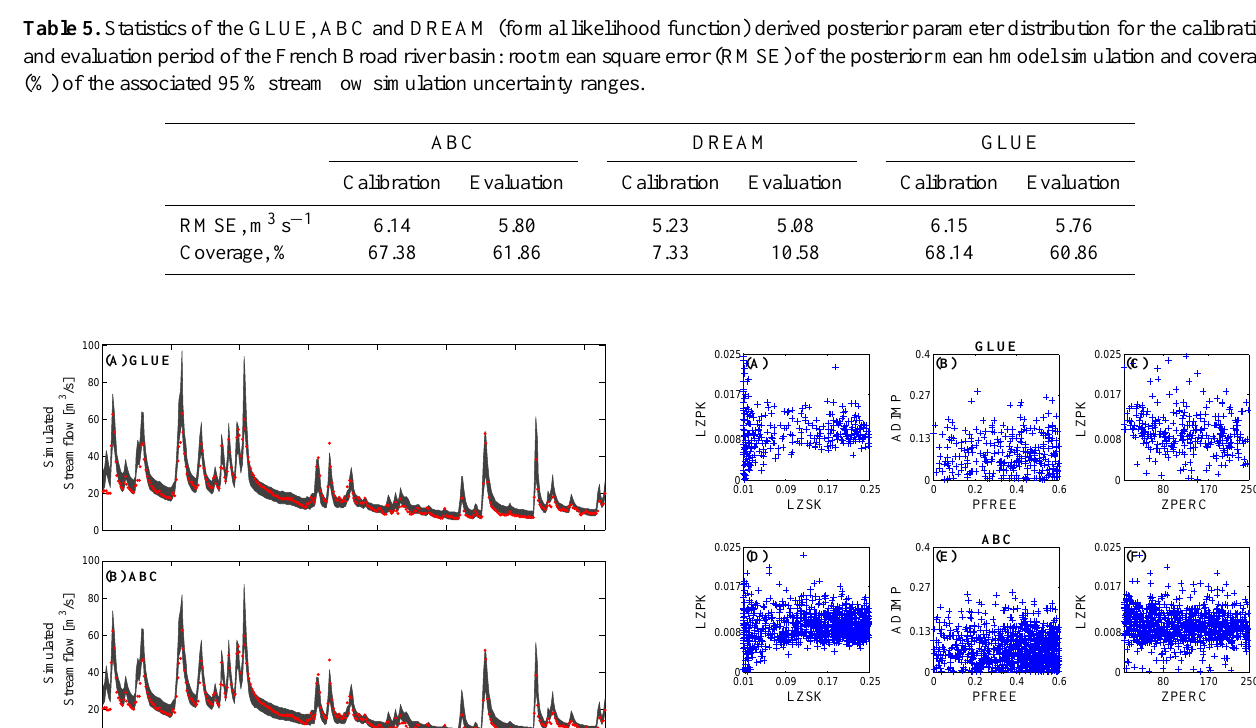
Fig. 7. Bivariate scatter plots of the behavioral (posterior) sam- ples of three different (randomly selected) parameter pairs using GLUE (top panels) and ABC (bottom panels): (A) LZSK-LZPK, (B) PFREE-ADIMP, and (C) ZPERC-LZPK. The scatter plots de- rived with both methods are in close agreement but demonstrate an important difference in sampling density. The computational bud- get of GLUE was limited to approximately 2 days, and within this time frame the Latin hypercube sampling method located only 300 behavioral